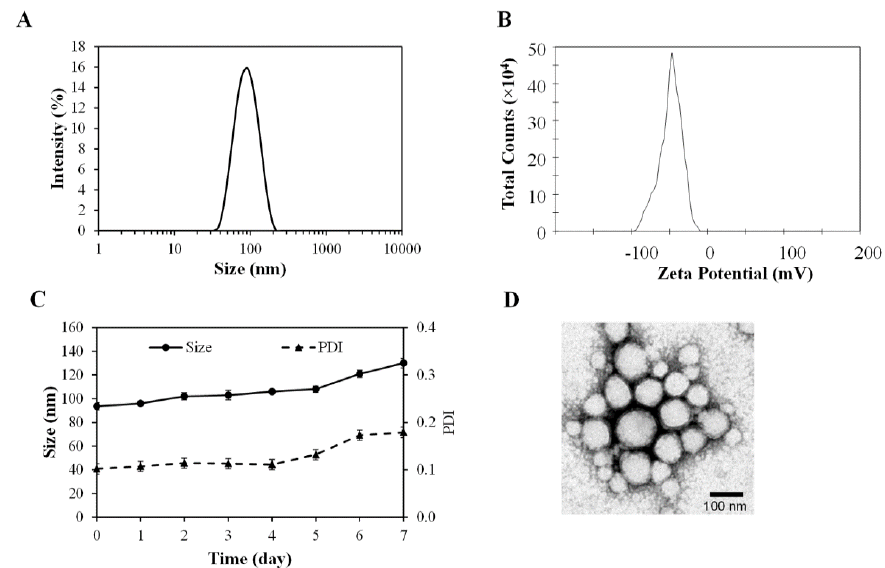
Figure 3. Physicochemical characterization of biotin functionalized polymeric nanoparticles. ( A ) Hydrodynamic size of PLGA nanoparticles showing Z-average of 95 ± 5 nm. ( B ) Zeta potential of PLGA nanoparticles demonstrates the negative charge property of PLGA nanoparticles. ( C ) A stability of PLGA nanoparticles in ionic condition (pH 7.4). ( D ) Representative TEM image of PLGA nanoparticles with core-shell structure.